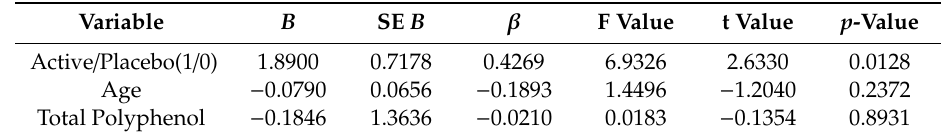
Table 8. Multiple Regression Analysis of the change score of MoCA with the amount of daily intake of polyphenol. Variable